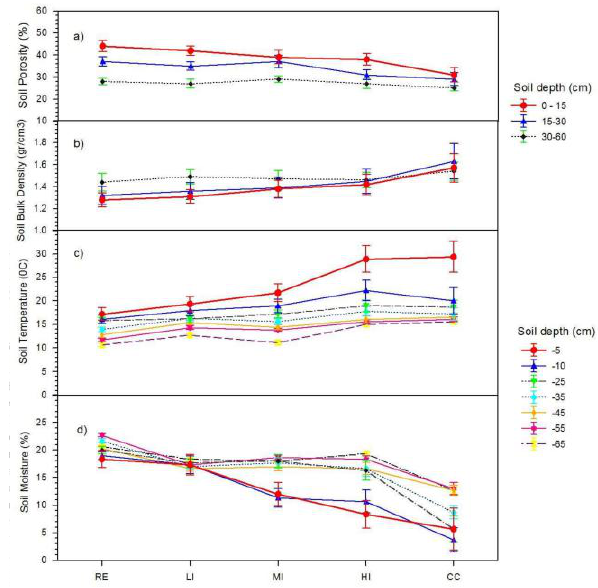
Figure 4. Comparison of soil porosity, soil bulk density, soil temperature, and moisture at different depths in the soil